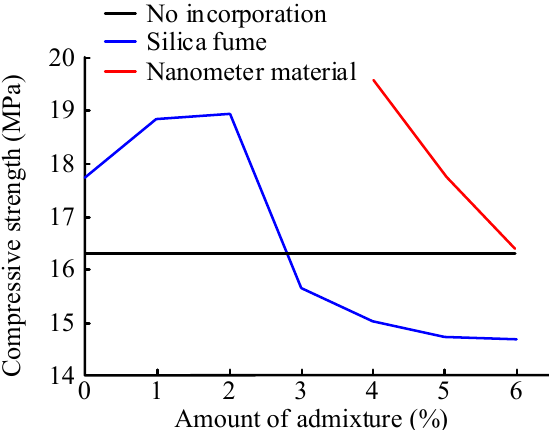
Figure 7. Difference in compressive strengths of pervious concrete.